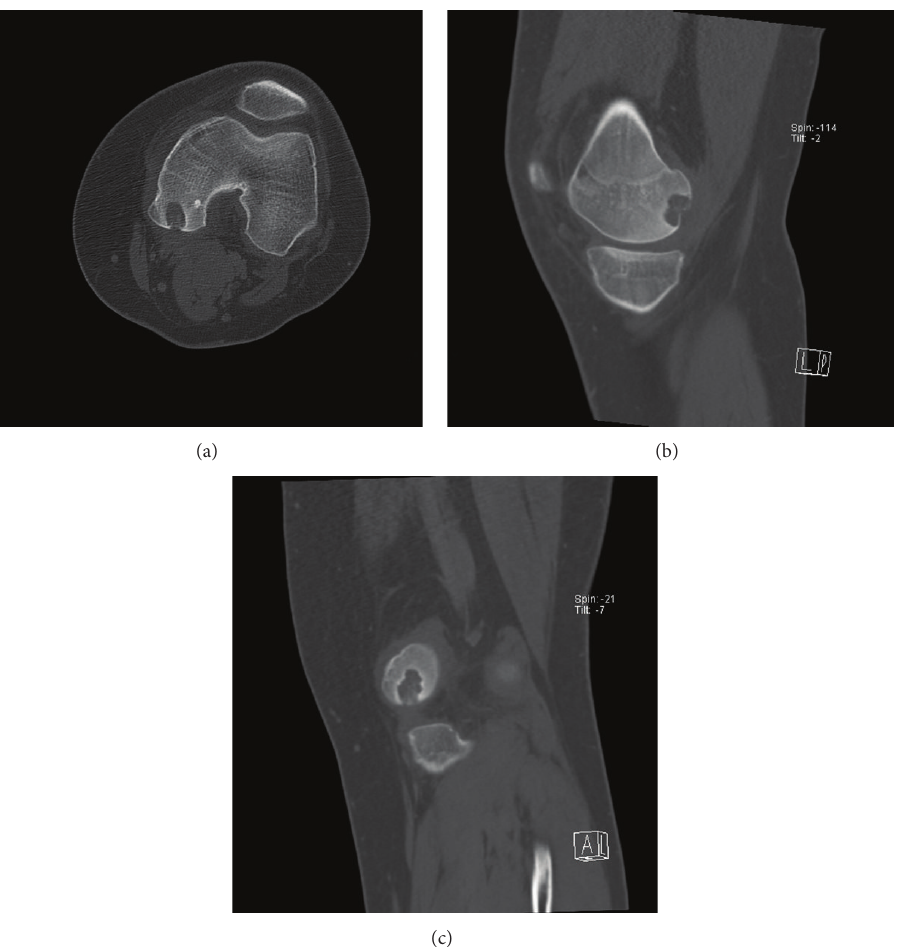
Figure 1: Axial (a), sagittal (b), and coronal (c) images from preoperative CT scan demonstrating a lytic lesion in the medial femoral condyle with lobulated well-defined margins and depression of the subchondral bone at the lesion border.